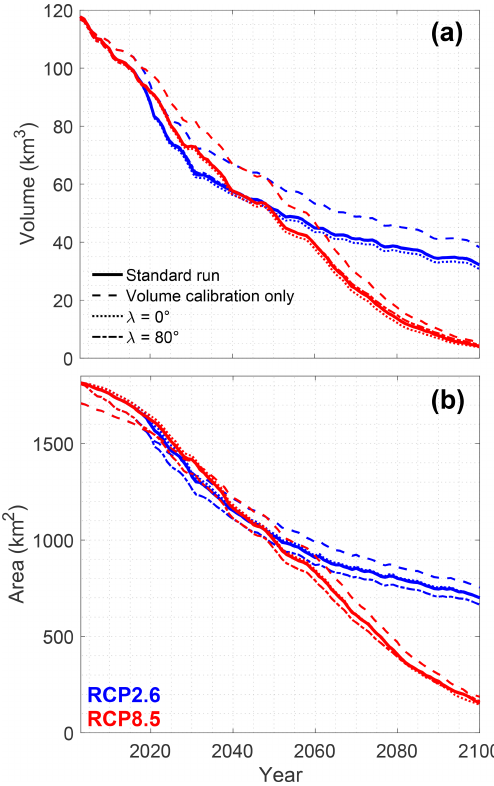
Figure 15. Sensitivity of volume (a) and area (b) for different cross- sectional geometries and under a different calibration procedure. Results are shown for all 795 glaciers for which the future evolution is simulated with the dynamic model. The standard calibration with λ = 45 ◦ corresponds to the classic setup. The colours correspond to different RCPs. Only the RCM simulation closest to the multi- model mean volume evolution is shown (dotted line in Fig. 8a; see also Table